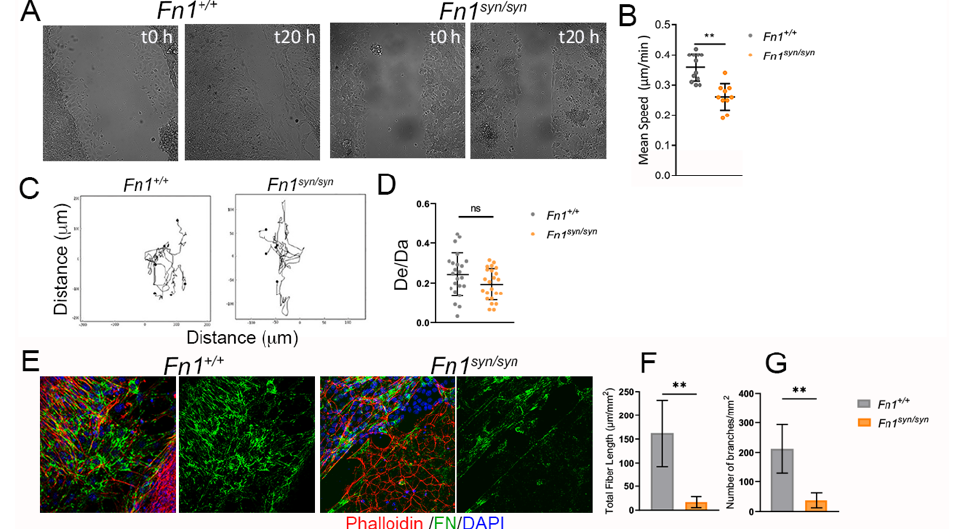
Figure 4. Characterization of Fn1 syn/syn fibroblast migration in scratch assays. ( A ) Representative scratch assays of Fn1 +/+ or Fn1 syn/syn fibroblasts at t0 and after 20 h in serum-free medium. ( B ) Quantification of the mean speed and ( C ) analysis and ( D ) quantification of the directionality (distance Euclidean/distance accumulated; De/Da) of cells at the wound edge. Values in graphs are the mean ± SEM of 6 different leading cells from 4 different experiments. ( E ) Immunofluorescences to show FN (green) fibrils assembled by migrating fibroblasts after scratching. ( F ) Quantification of total FN fibril lengths and ( G ) number of branched FN fibrils per area. Values represent 4 images per condition. Statistically significance was determined using the Student’s t -test p -value ** p < 0.01. 3.4. Myofibroblast Conversion Is Reduced in the Absence of the FN Synergy Site To test whether the reduced numbers of myofibroblasts in the GT of Fn1 syn/syn wounds were due to an abnormal conversion of dermal fibroblasts to myofibroblasts, we seeded primary Fn1 +/+ and Fn1 syn/syn dermal fibroblasts (DFs) on PA gels of 4 kPa, 50 kPa and on glass coverslips coated with either pFN wt or pFN syn (Figure 5A). After 24 h in culture, the percentage of α -SMA positive myofibroblasts was calculated. As expected, increased rigidity increased the proportion of Fn1 +/+ myofibroblasts, from 50% (on 4 kPa) to 61% (on 50 kPa). However, in the absence of a functional FN synergy site, the myofibroblast conversion was significantly reduced to 43% (on 4 kPa) and 50% (on 50 kPa), respectively (Figure 5B). On glass, however, differences between genotypes were lost. TGF- β 1-induced cell signalling contributes to fibroblast-to-myofibroblast differentia- tion [33]. TGF- β 1 is secreted as part of the large latent complex (LLC), which, in addition to TGF- β 1, consists of latency-associated protein (LAP) and latent TGF- β binding protein 1 (LTBP-1). The LLC provides a reservoir of latent TGF- β 1 in the ECM by binding to ECM components, mainly fibrillin-1 and FN [34–37]. The traction forces produced by myofibrob- lasts on FN fibrillar networks have been demonstrated to contribute to TGF- β 1 release from its latent complex [22]. Thus, we directly tested TGF- β 1 release from FN matrices. To that end, we performed a bioassay to measure TGF- β 1 in conditioned media by Fn1 +/+ and Fn1 syn/syn dermal fibroblasts after 3 days of culture. Interestingly, although the